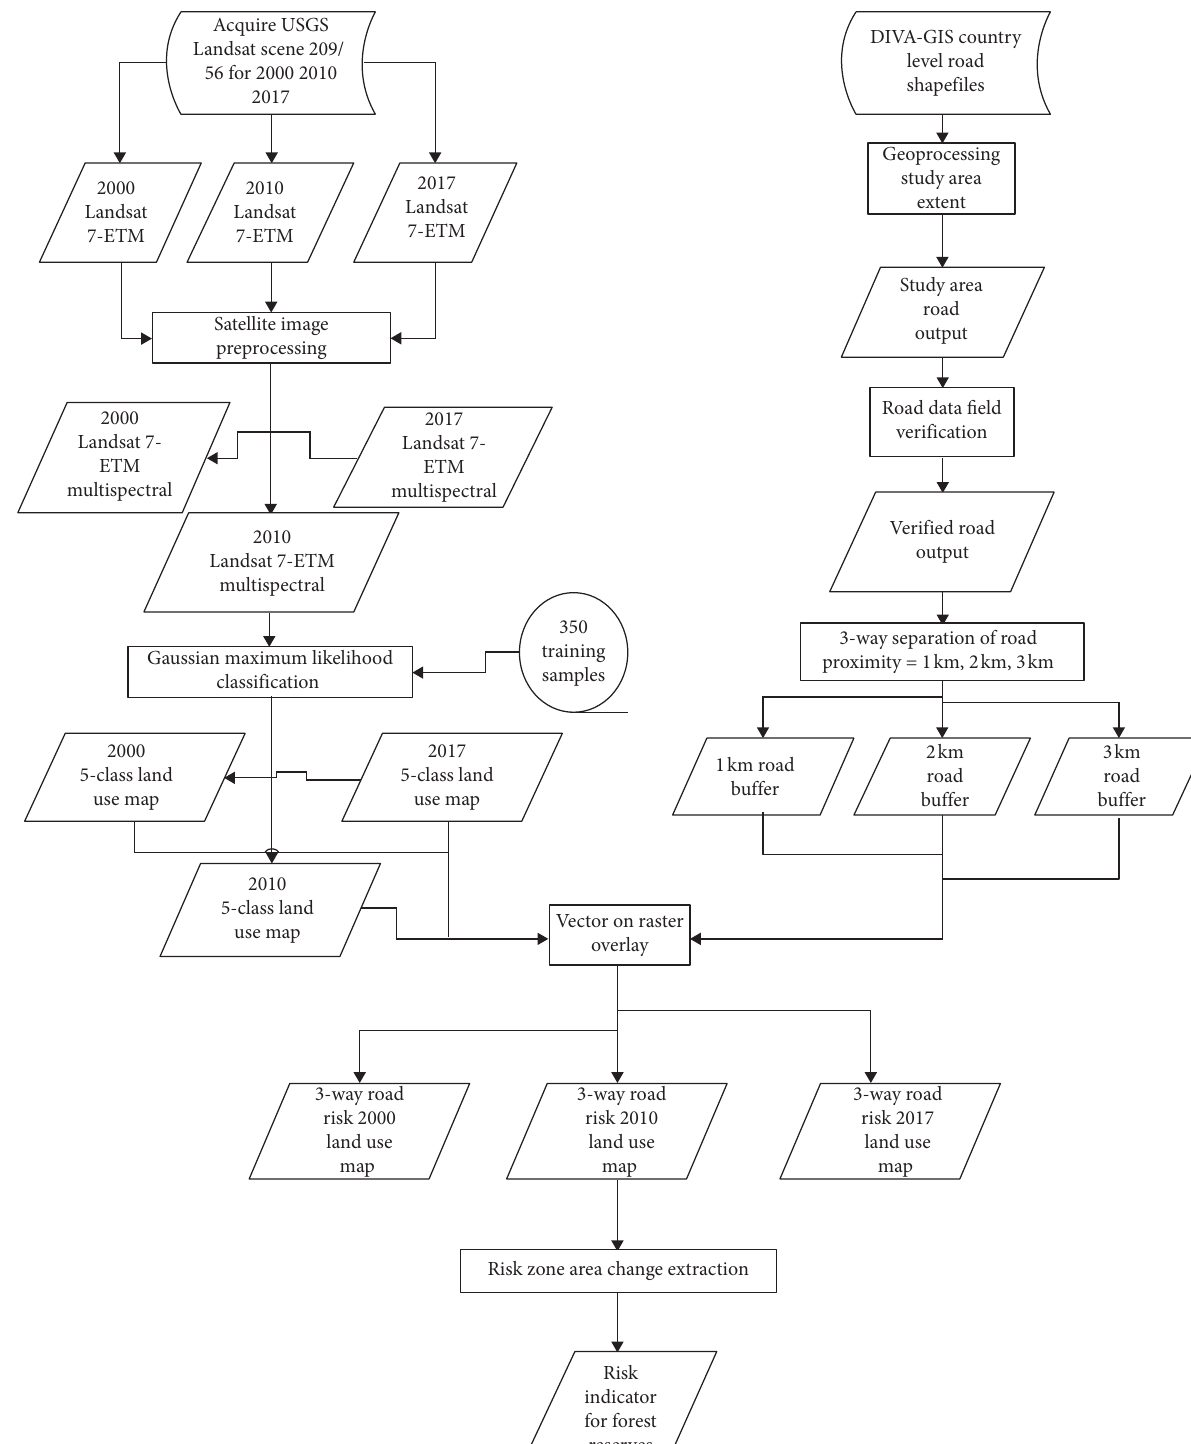
Figure 4: A workflow of road shapefile processing and subsequent LULC